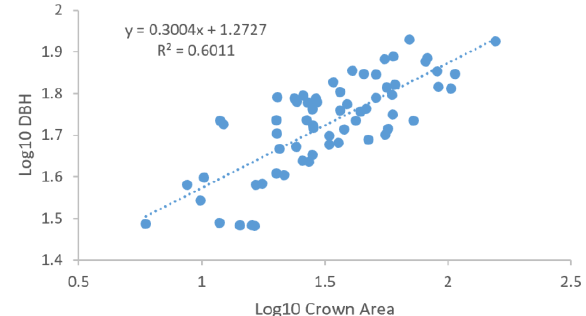
Figure 11. Relationship between DBH and Crown Area